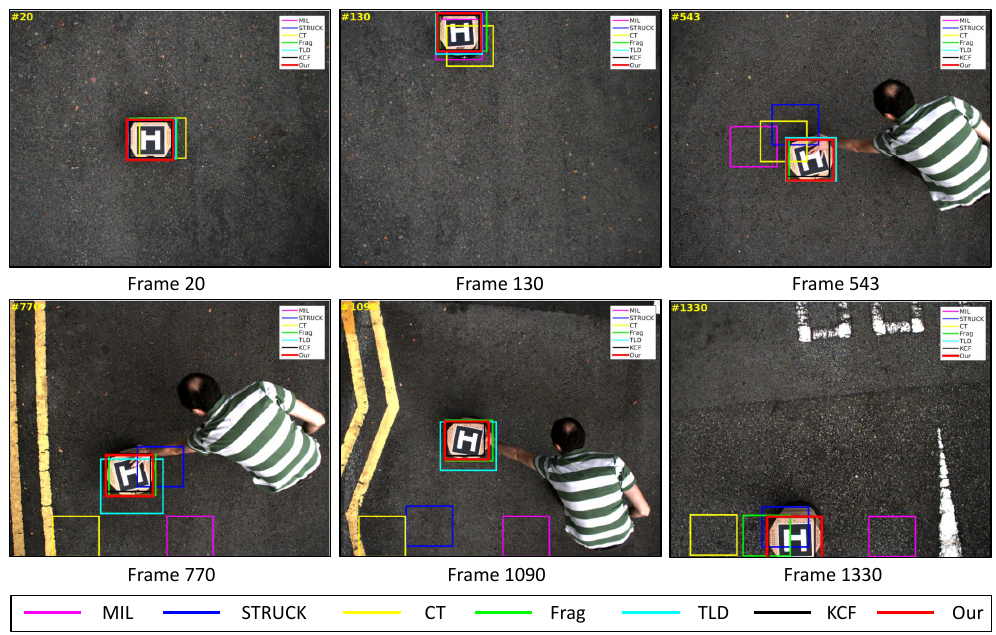
Figure 21. Some tracking results in the UGV lp image sequence. The total number of frames: